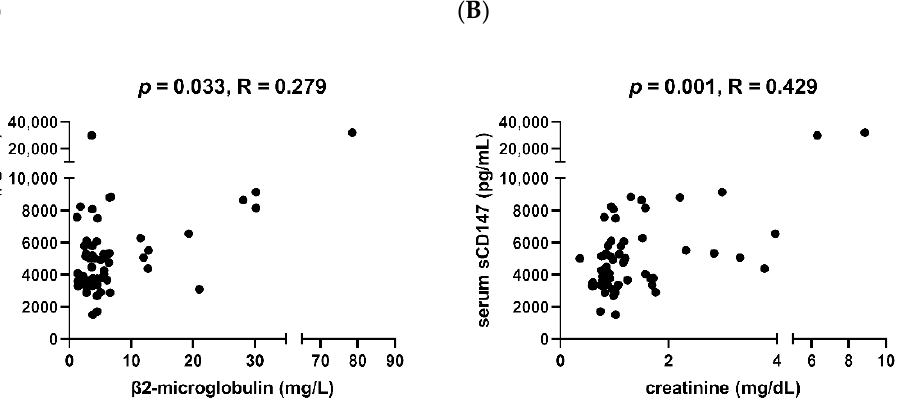
Figure 3. Correlation between serum soluble CD147 and two clinical parameters in MM patients— β2-microglobulin ( A ) and creatinine ( B ). Serum soluble CD147 is characterized by a weak-moder- ate correlation with these two parameters.